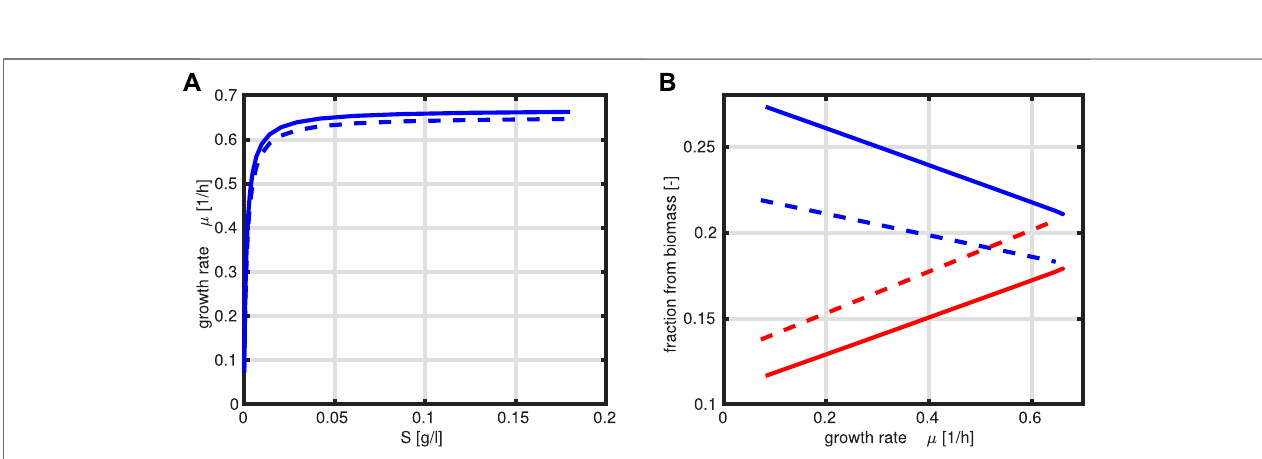
FIGURE 3 | Relationship between the sectors T and R as a function of the speci fi c growth rate μ . Experimental data are taken from the study by Schmidt et al., (2016) with protein representing 50% of the biomass (A) . Estimated kinetics of fi rst order for T / P and R / P as a function of variable M (B) .